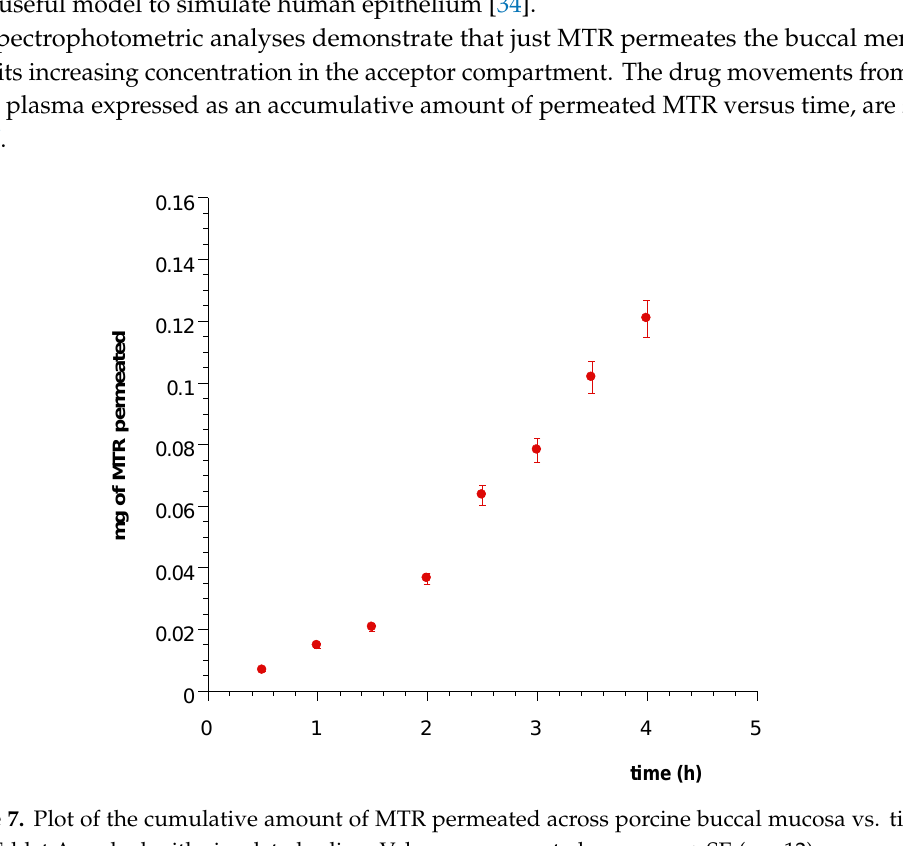
Figure 8. Linear fit at the steady state of MTR permeation per cm 2 of porcine sublingual mucosa.